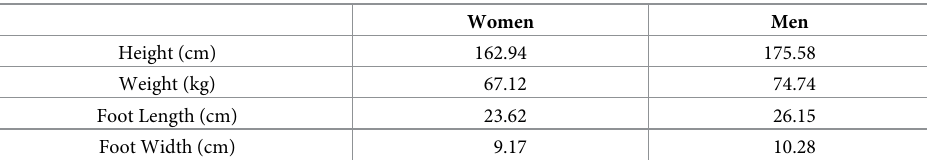
Table 2. Anthropometric values [56–58].